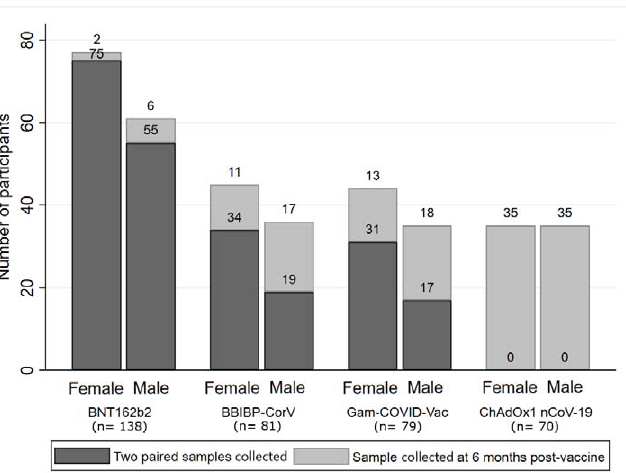
Figure 1. Distribution of participants, stratified by vaccine type, sex and number (single or paired) of samples.